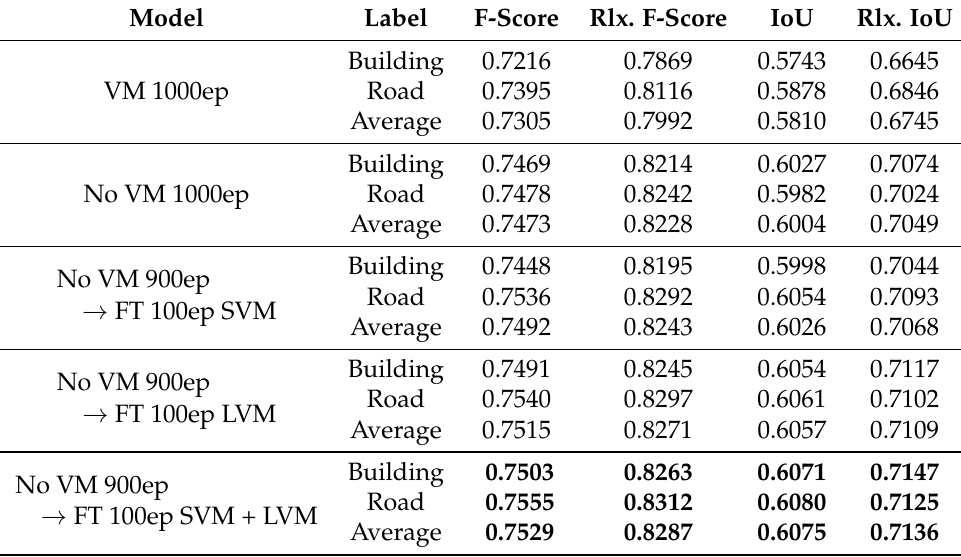
Table 4. Assessing the impact of validation masks.